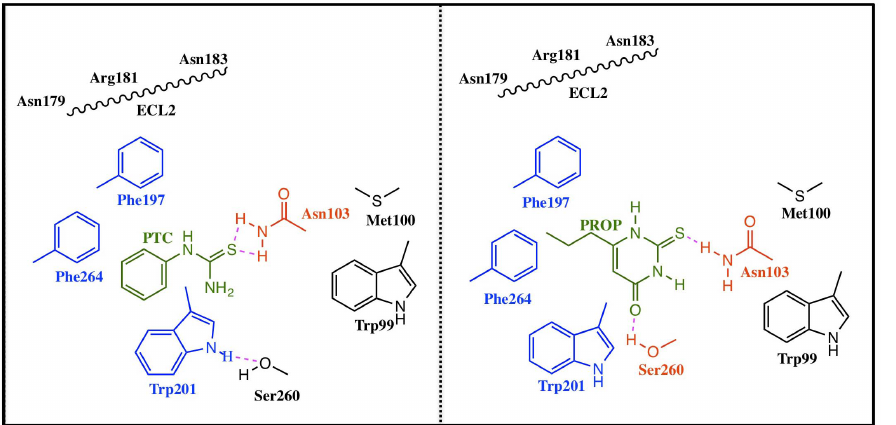
Figure 7. Agonists binding. Binding of PTC and PROP to the TAS2R38 bitter receptor as emerging from MM/CG simulations and experiments. Residues forming hydrophobic interactions and H-bonds with the agonists are indicated in blue and red, respectively. Residues shaping the cavities are in black color. The ECL2 loop does not interact directly with the agonists.